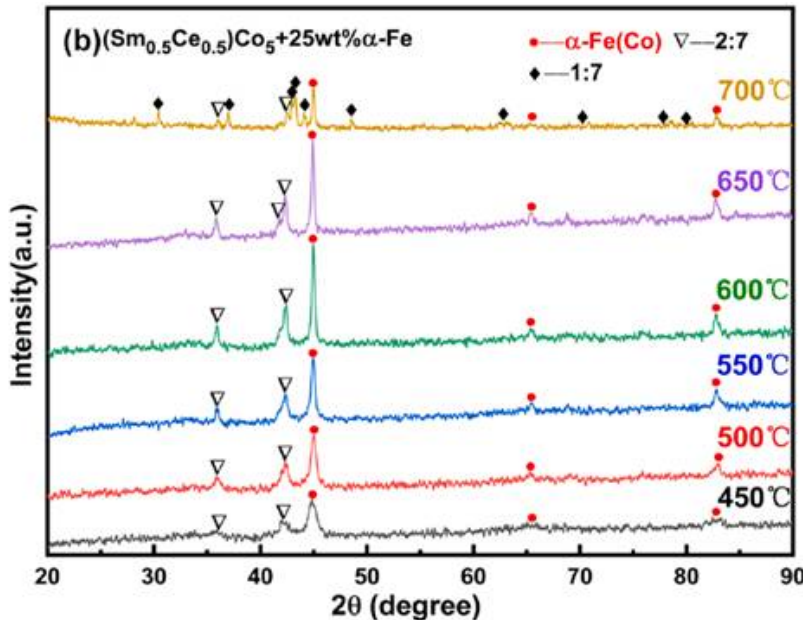
Figure 10. XRD patterns of ( a ) La-doped SmCo 5 / α -Fe ( b ) Ce-doped SmCo 5 / α -Fe at different anneal- ing temperatures [96]. (License obtained to use this Figure from Elsevier Publications, Journal of Magnetism and Magnetic Materials).